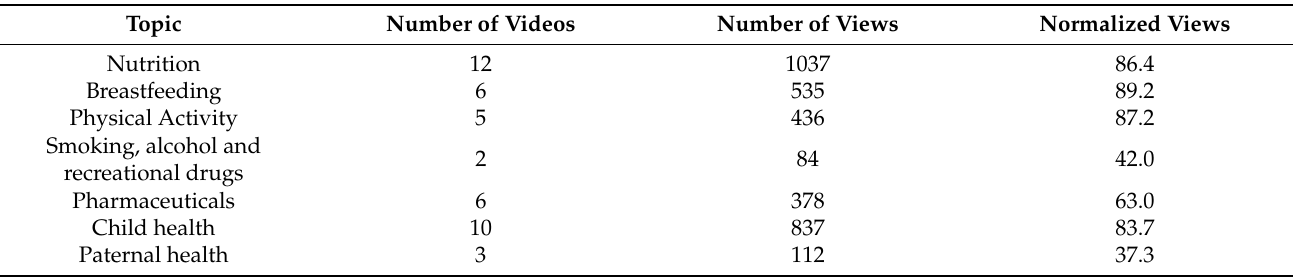
Table 3. Normalized number of views by